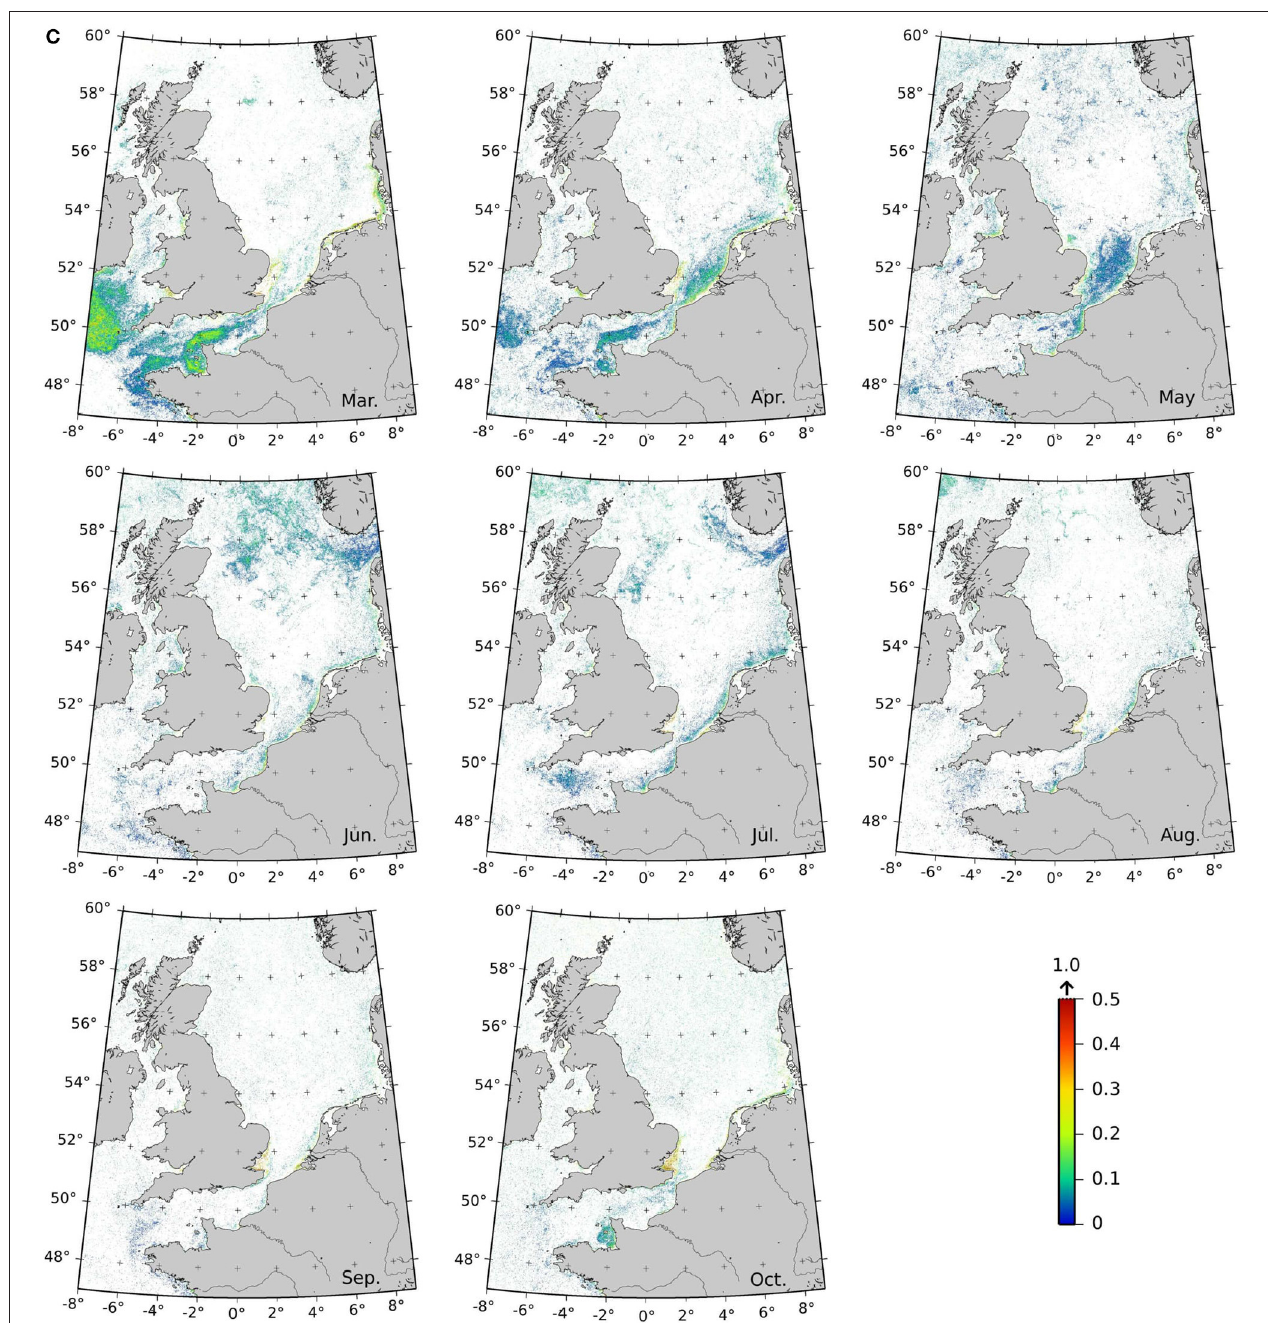
FIGURE 7 | Climatology maps of labeled Ra( λ ) classes detection frequencies (SeaWiFS level 2 data over 1998–2004) for Ra( λ ) classes labeled as (A) Thalassionema nitzschoides assemblage ; (B) Thalassiosira spp. assemblage ; and (C) Rhizosolenia imbricata assemblage. Frequencies are computed by dividing the number of labeled Ra( λ ) over the month (with a minimum of three occurrences) by the number of total Ra( λ ) classes occurrence (labeled at this stage or not). If more than one Ra( λ ) is labeled for a given assemblage, their frequencies are added. Please note that the color scales are different for the three distributions. White pixels means that less than 3 occurrences are recorded in the month. Due to high-solar zenith angle in the boreal Winter (November to February), signal could not be retrieved poleward 52 ◦ N and thus, only the results for the months of March to October are shown.